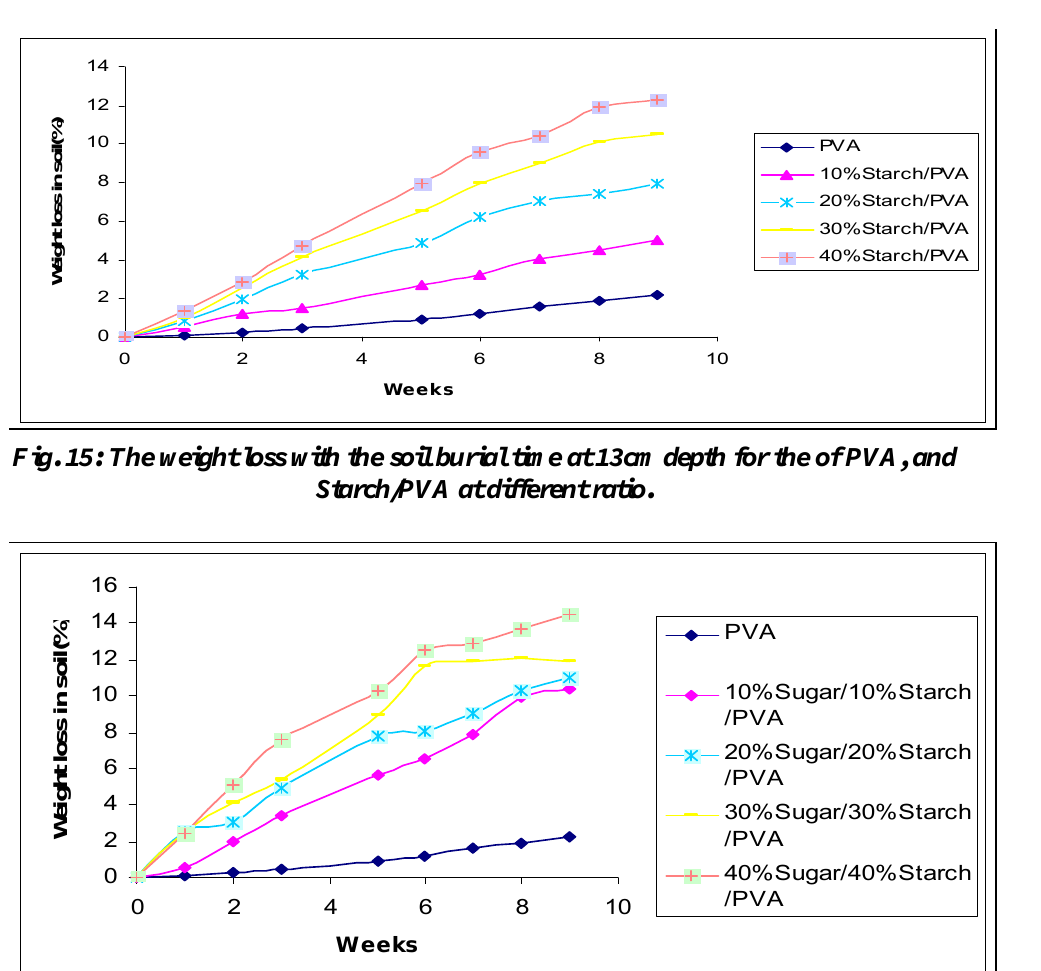
Fig. 14: The weight loss with the soil burial time at 3cm depth for the of PVA, and Starch/PVA/sugar at different ratio.